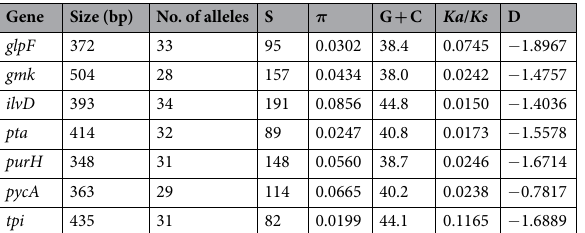
Table 2. Characteristics of seven housekeeping genes from 82 strains. Notes: S, number of variable sites; π , nucleotide diversity (per site); G + C, the mean G + C content; Ka / Ks , the number of non-synonymous